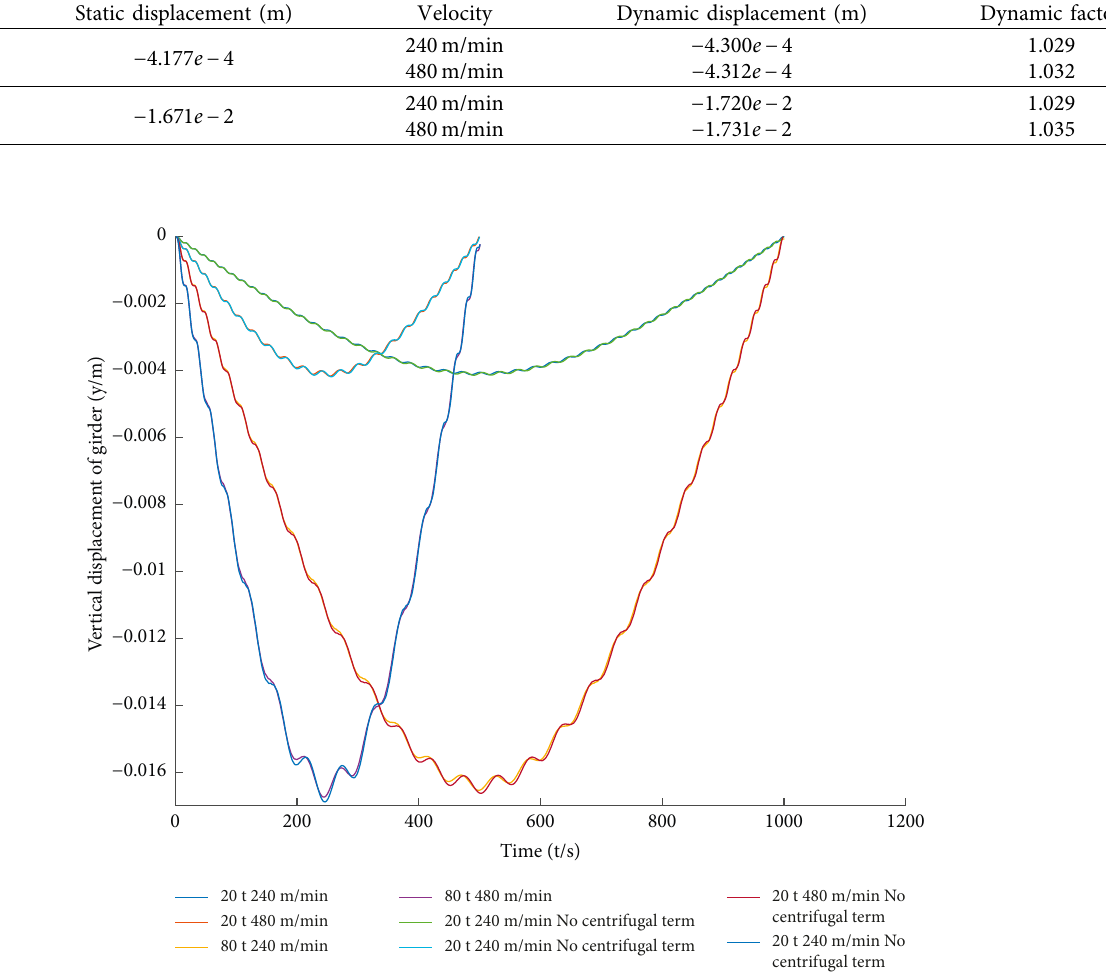
Figure 9: Displacement result considering the centrifugal